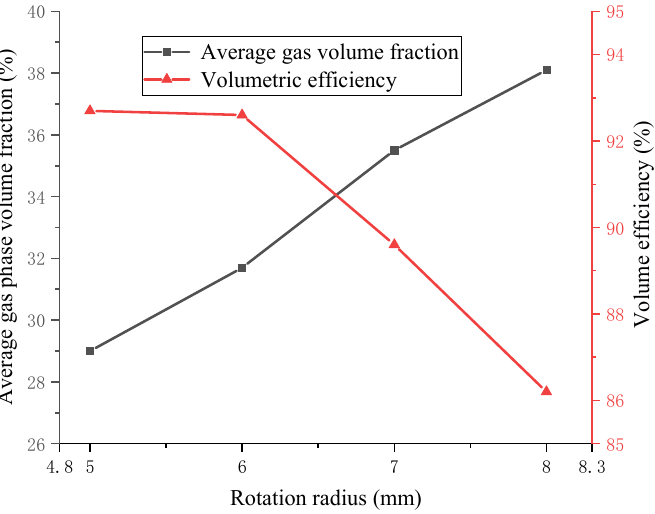
Figure 13. Average gas-phase volume fraction and volume efficiency at different rotation radii.